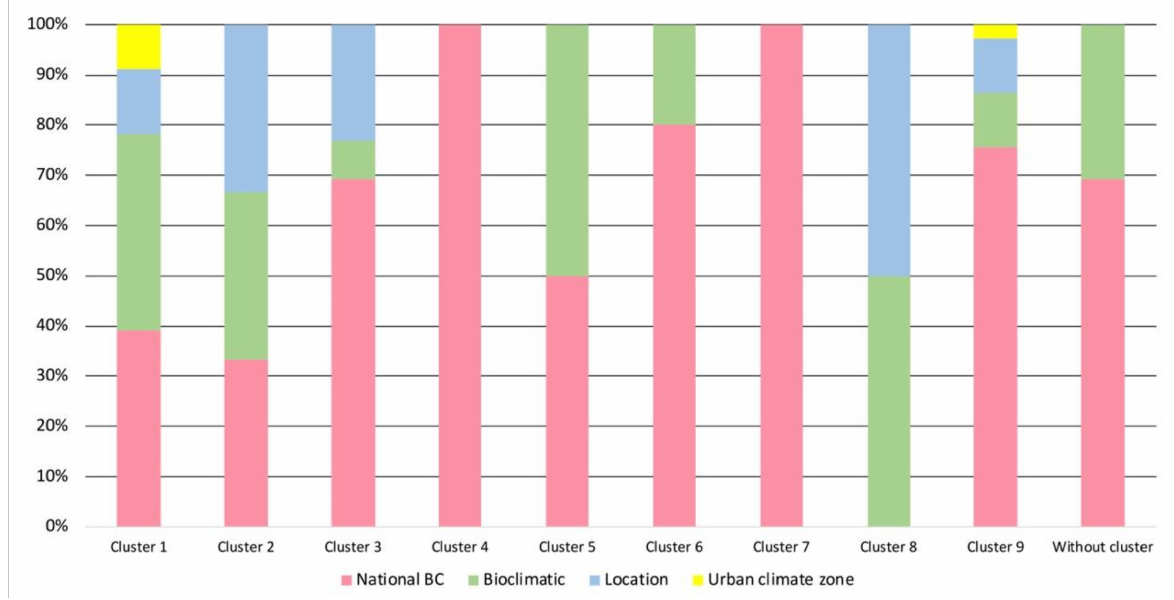
Figure 8. Main climate zonings for the